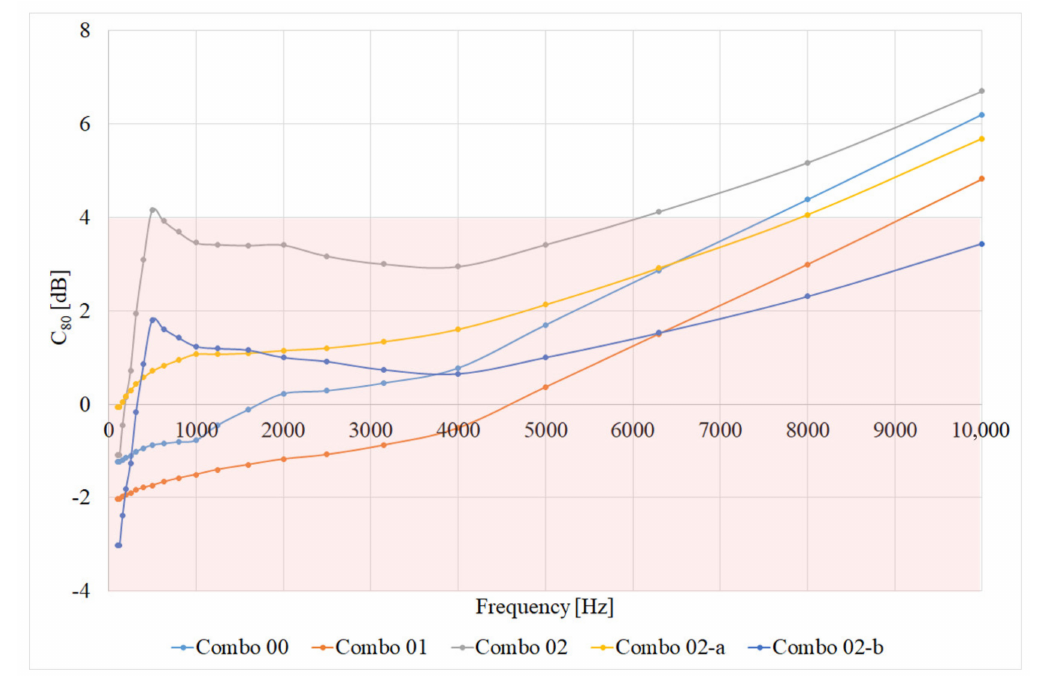
Figure 11. Clarity index C 80 of numerically simulated Combos with (Combos 00, 01, 02-a) and without (Combos 02 and 02-b) the presence of the audience.